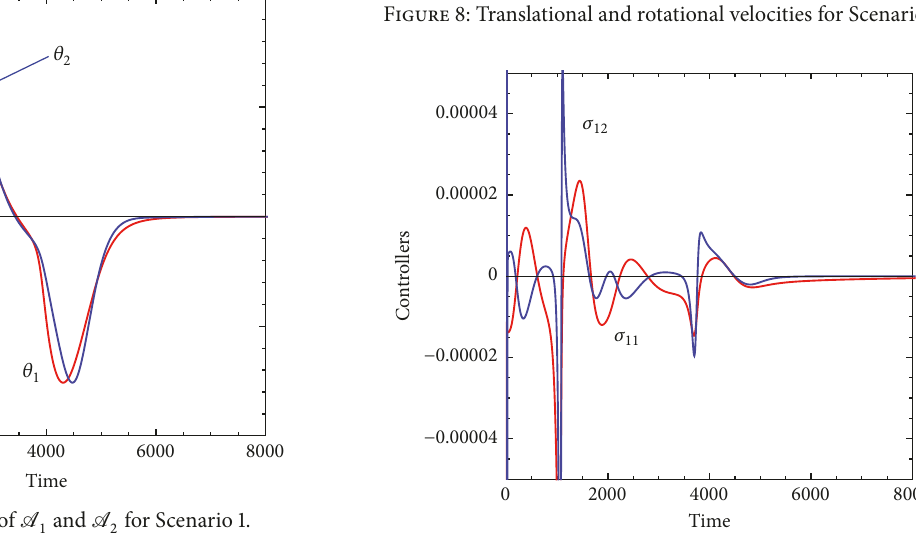
Figure 8: Translational and rotational velocities for Scenario 1.